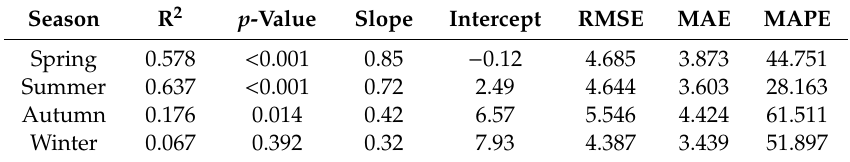
Table 6. Statistics showing the seasonal performance of the GROC4 algorithm in Chesapeake Bay.